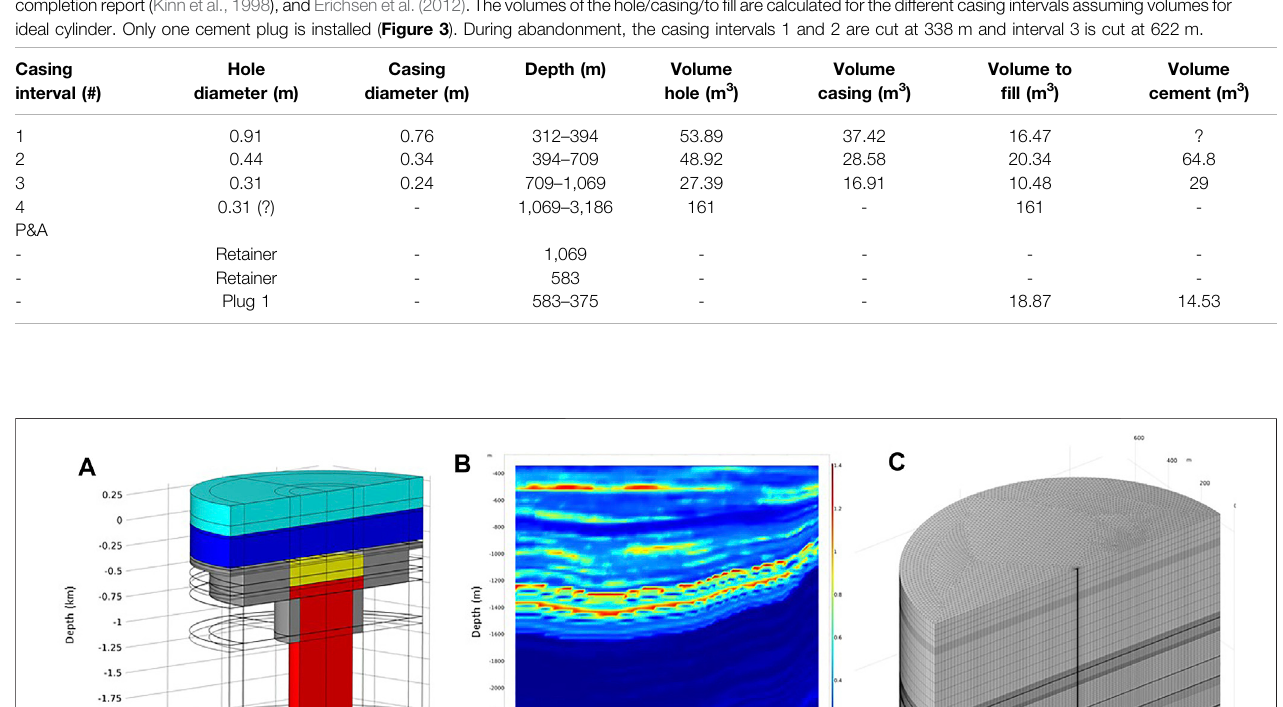
Frontiers in Energy Research |